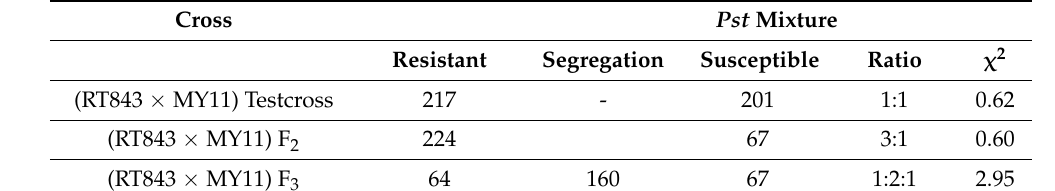
Table 2. Resistance segregation to Pst in the backcross RT843-5 × MY11.